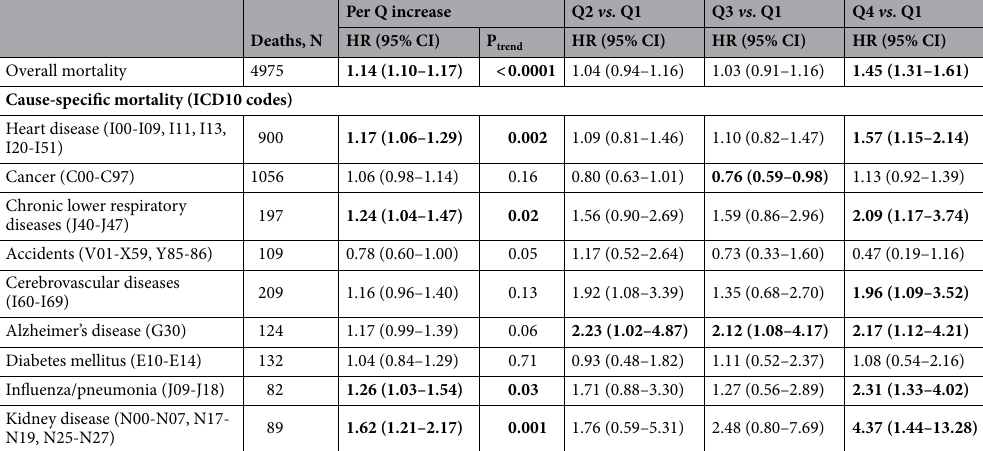
NLR and preexisting disease was significant (P interaction = 0.01) only for chronic lower respiratory disease.